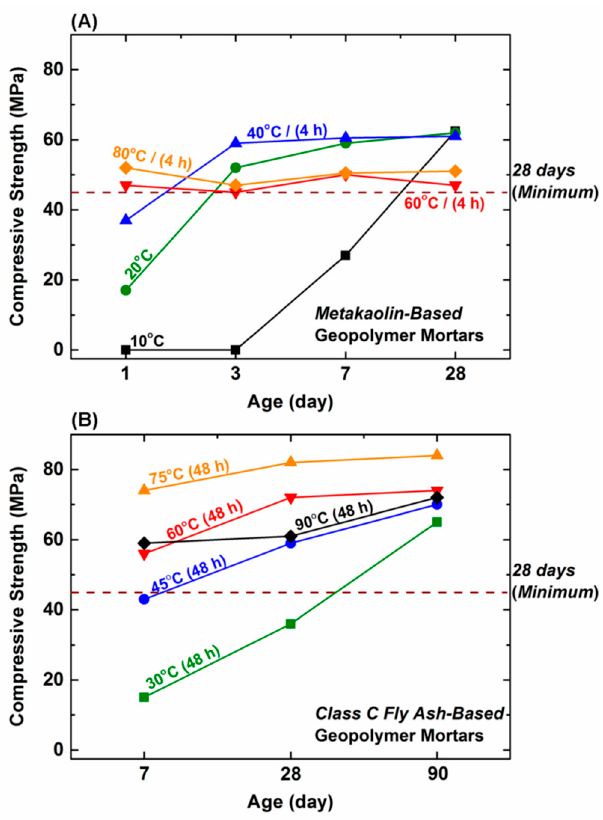
Figure 1. Compressive strength variation as a function of ageing under ambient conditions (~25 °C), following initial curing conditions (as indicated) of ( A ) metakaolin + sodium silicate based geopolymer mortars and ( B ) Class C fly ash + sodium silicate geopolymer mortars. Adapted from [15,16].